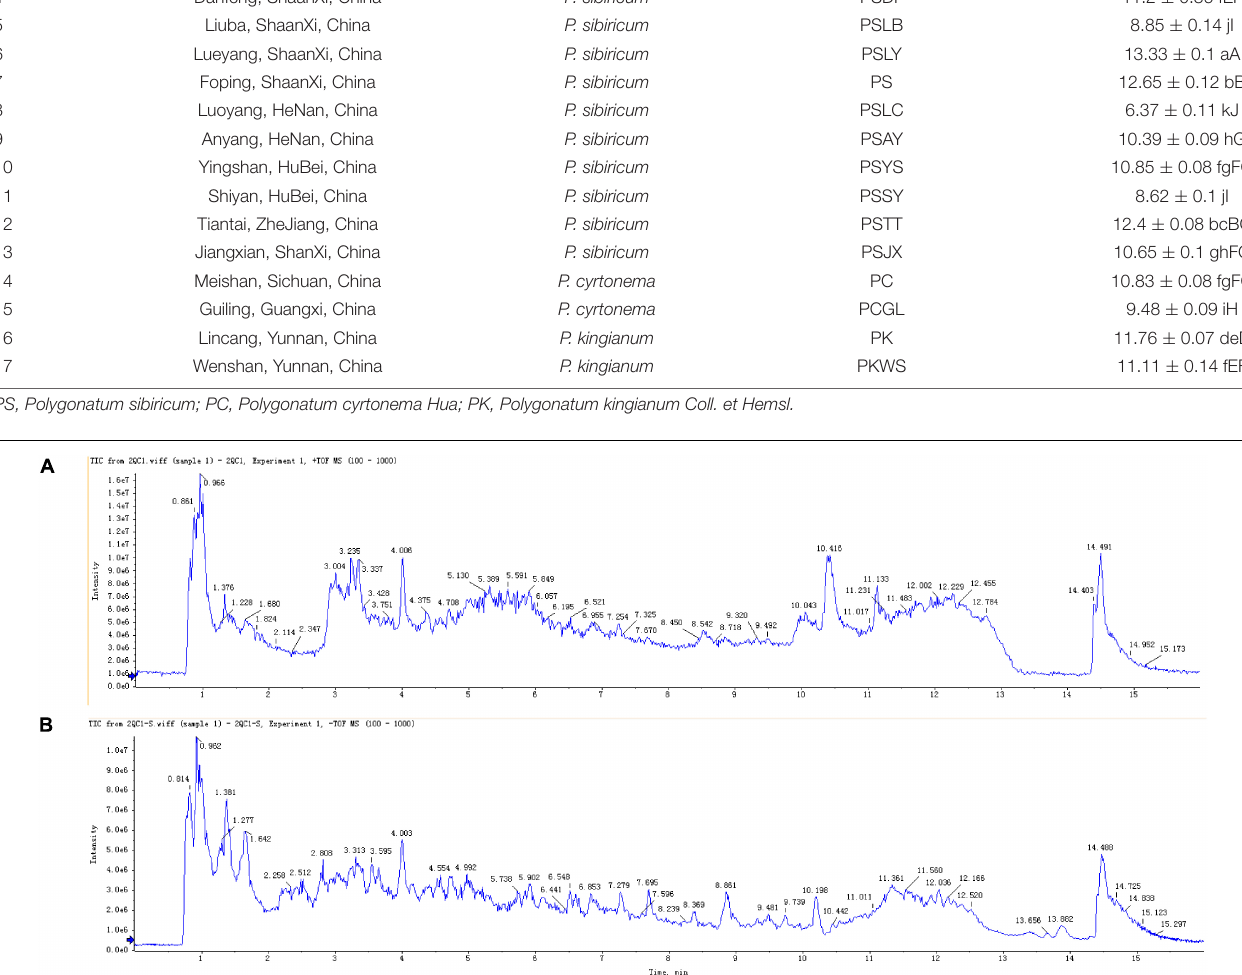
(negative ion mode) ( Figures 2C,E ). The abscissa is the first principal component score, represented by PC1; The ordinate is the second principal component score, represented by PC2, and the parentheses are the percentage of the explained